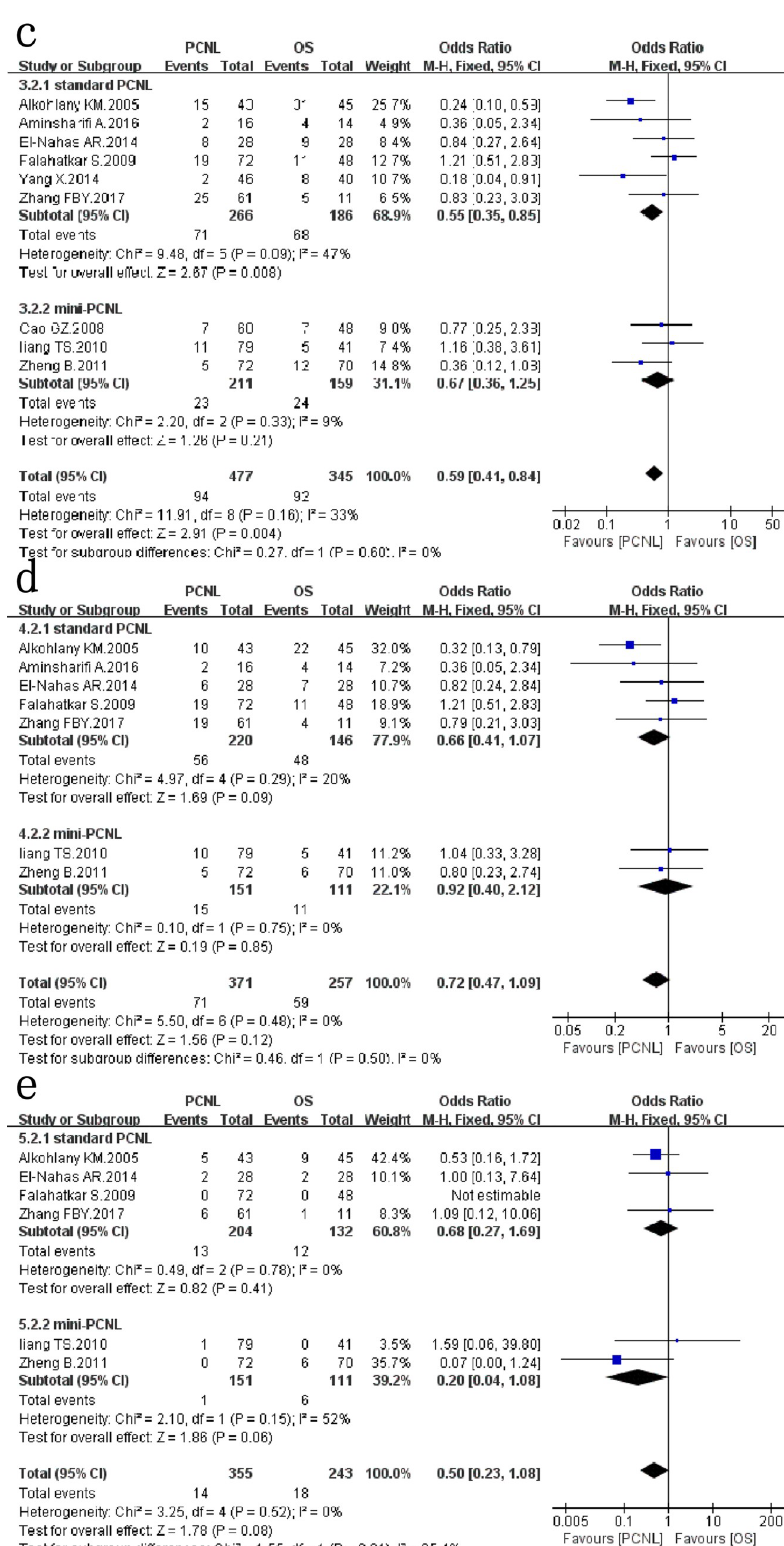
Fig 3. Forest plot and meta-analysis of overall complications(c), minor complications(d) and major complications (e). https://doi.org/10.1371/journal.pone.0206810.g003 PLOS ONE | https://doi.org/10.1371/journal.pone.0206810 January 31,